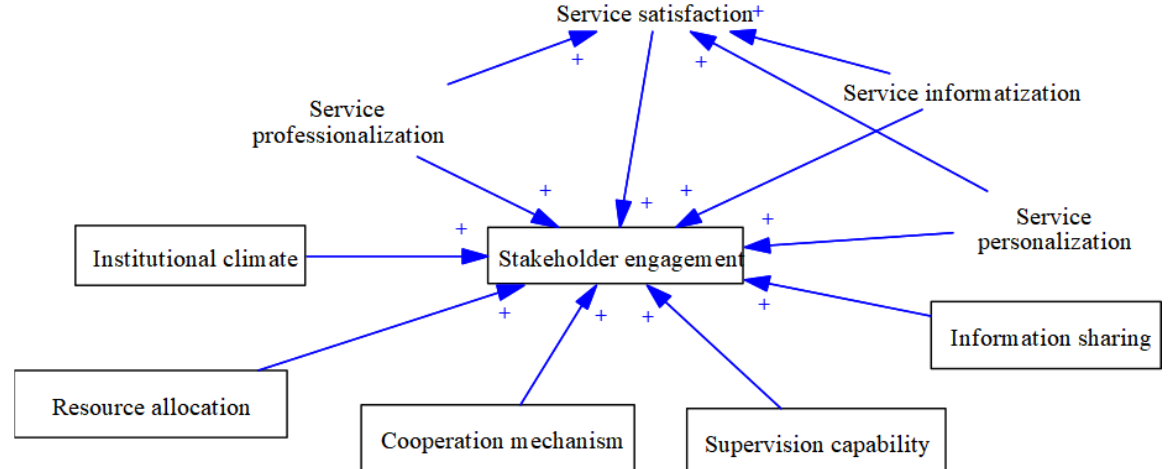
Figure 7. The causal-loop diagram of SE.